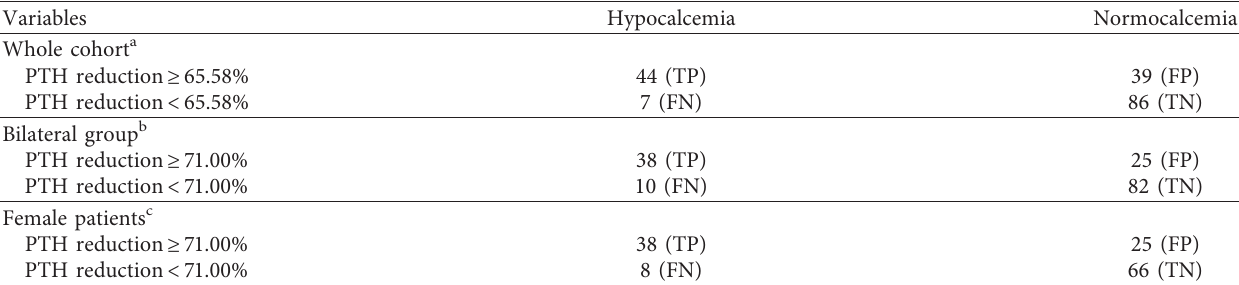
Figure 2: The ROC curves for various patients: (a) the ROC curve analysis of PTH reduction in predicting postoperative day 1 hypocalcemia in the whole cohort ( n � 176); (b) the ROC curve analysis of PTH reduction in predicting postoperative day 1 hypocalcemia in patients who underwent thyroidectomy with bilateral central lymph node dissection (bilateral group, n � 155); (c) the ROC curve analysis of the PTH decrease in predicting postoperative day 1 hypocalcemia in female patients ( n � 137). Table 5: The accuracy of PTH reduction in predicting hypocalcemia and normocalcemia in the whole cohort, bilateral group, and female